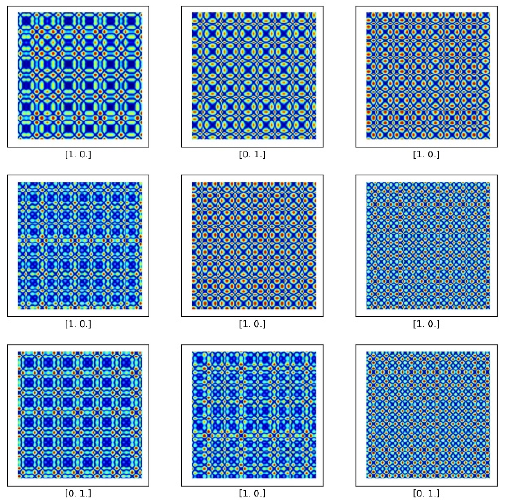
Figure 10. Unthresholded recurrence plot by chaos and non-chaos (chaos: [1 0], non-chaos: [0 1]).